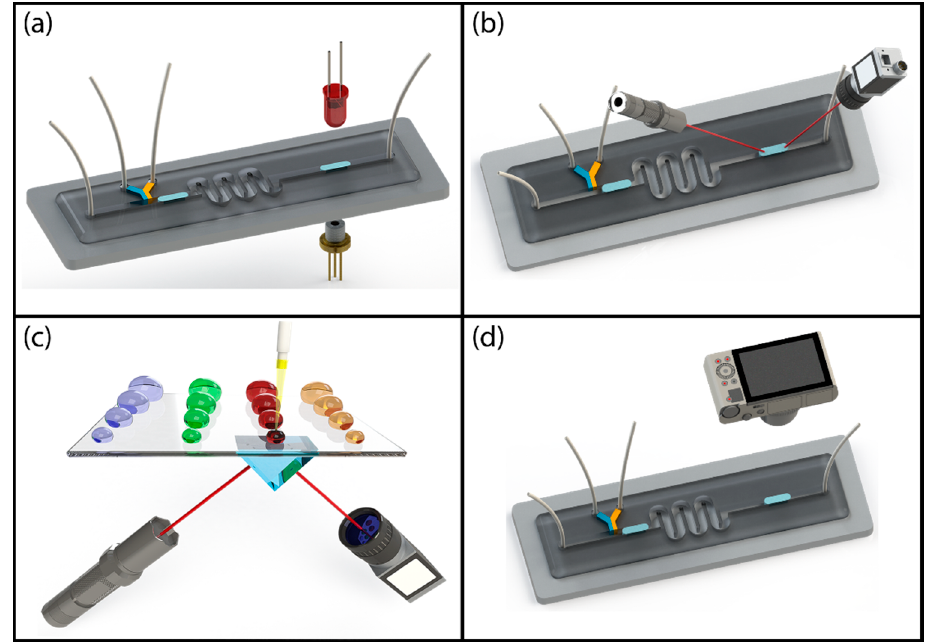
Figure 3. Schematic illustration of label-free optical detection techniques: ( a ) absorption spectroscopy; ( b ) vibrational spectroscopy; ( c ) evanescent field sensing; ( d ) image processing-based sensing.